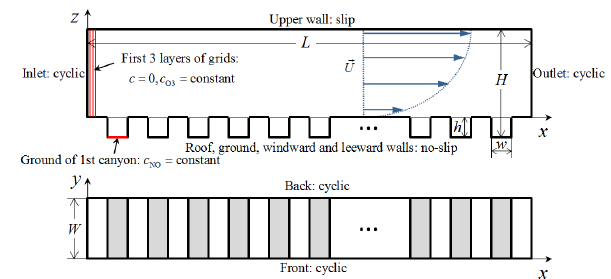
Figure 1. Computational domain and boundary conditions.